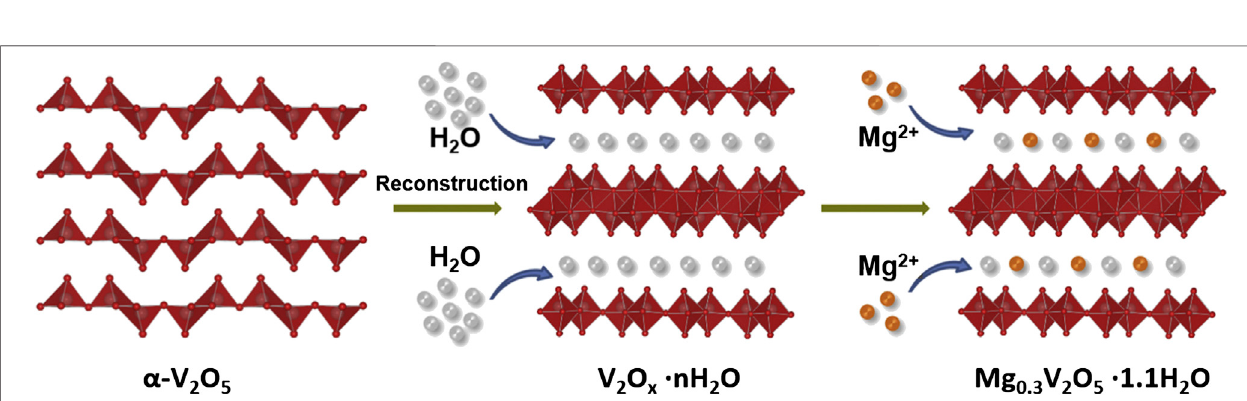
FIGURE 7 | Schematic Diagrams of the Formation of the Bilayer-Structured Mg 0.3 V 2 O 5 (cid:129) 1.1 H 2 O. Reprinted with permission from Chem 5, 1194 – 1209, May 9, 2019. Copyright Elsevier 2019.